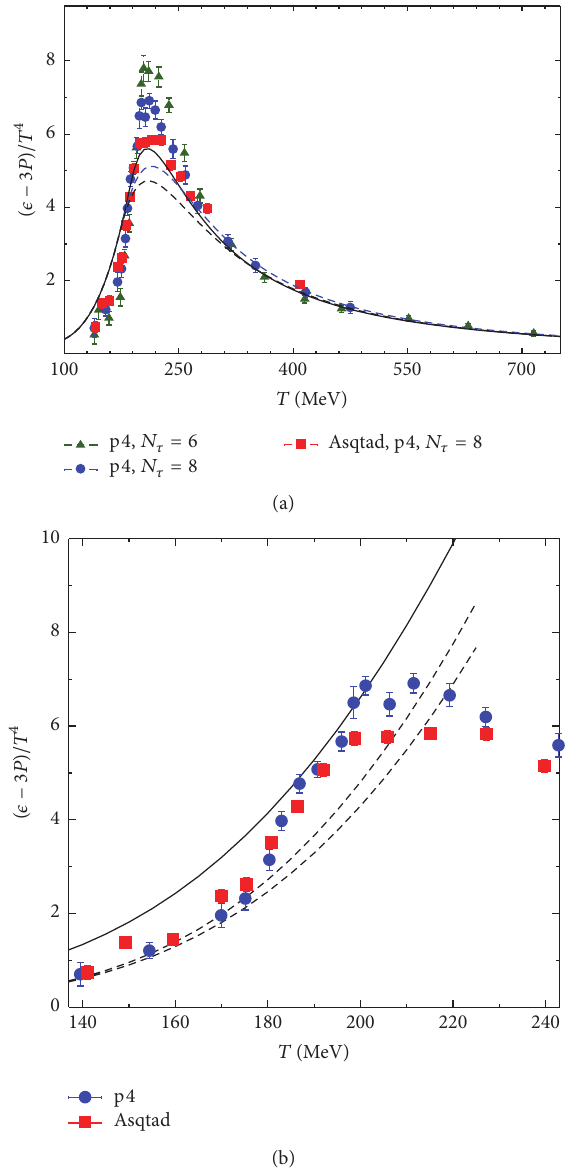
Figure 3: The trace anomaly calculated in lattice QCD with p4 and asqtad actions on 𝑁 𝜏 = 6 and 8 lattices compared with various parametrizations given by the solid, dotted, and dashed lines (a) and thetraceanomalycalculatedinlatticeQCDcomparedwiththeHRG model given by the solid and dashed lines (b). The figures are taken from